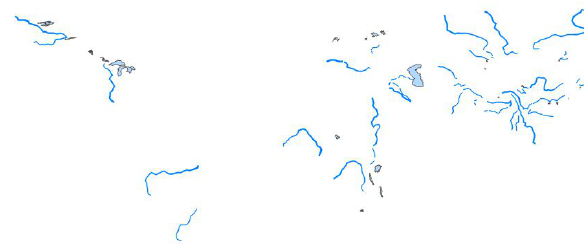
Figure 9.Local Comparison of Plate Generalization